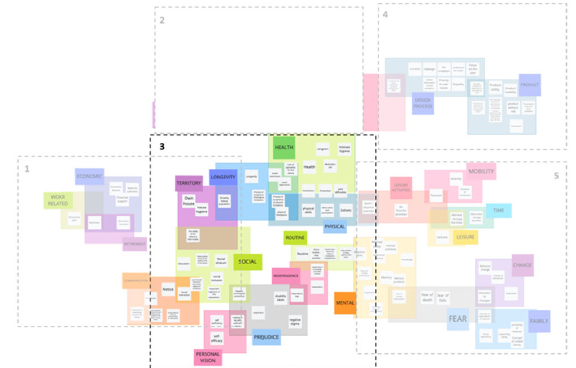
Figure A3. Map Section 3.